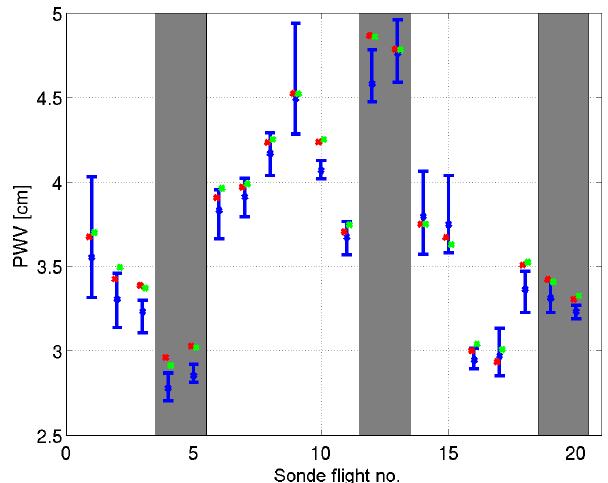
Figure 18. Comparison of precipitable water vapor for the RS92 (red), RS41 (green), and microwave radiometer (blue). Bars on the MWR observations represent the range of observed PWV during the first half hour of each balloon launch. Gray shading indicates nighttime sounding